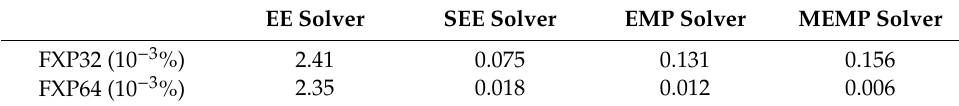
Table 1. The di ff erence in area for the spiking mode for DBL and FXP